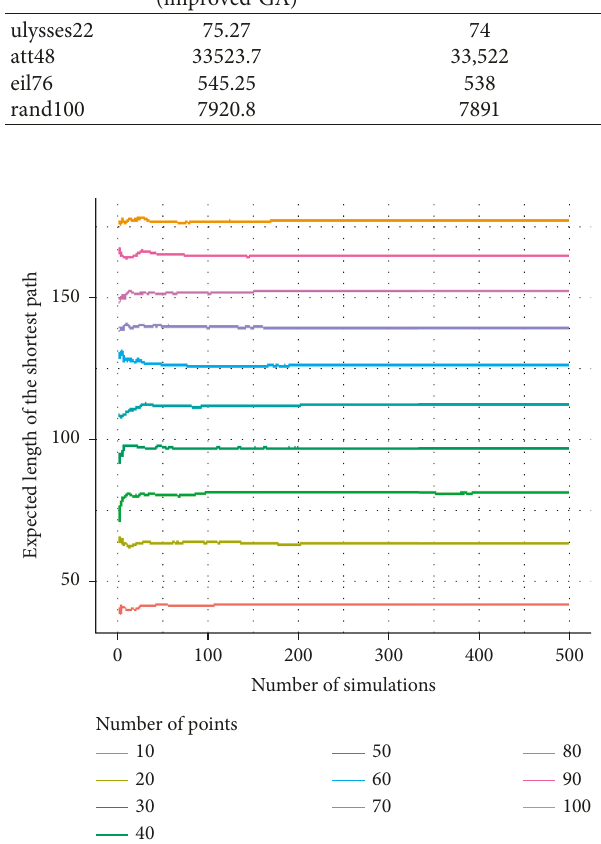
Figure 3: Relationship between the average length of the shortest path and the number of